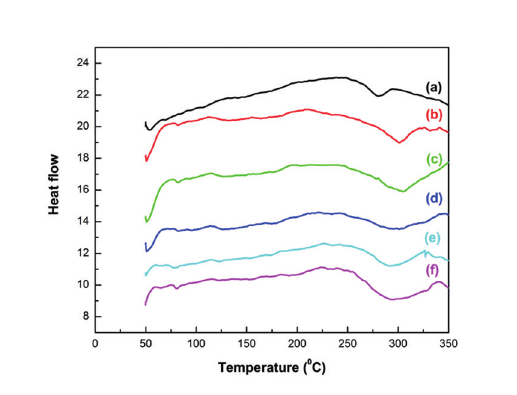
Figure 1: DSC curves of PVC polymer films containing Mn 2+ (a) pure (b) 1mol% (c) 2 mol% (d) 3 mol% (e) 4 mol% (f) 5